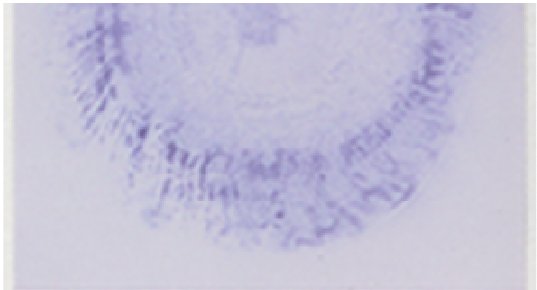
Figure 1. Glycyrrhizin immunocytolocalization in a fresh licorice root slice using an anti-glycyrrhizin monoclonal antibody (author’s unpublished data).